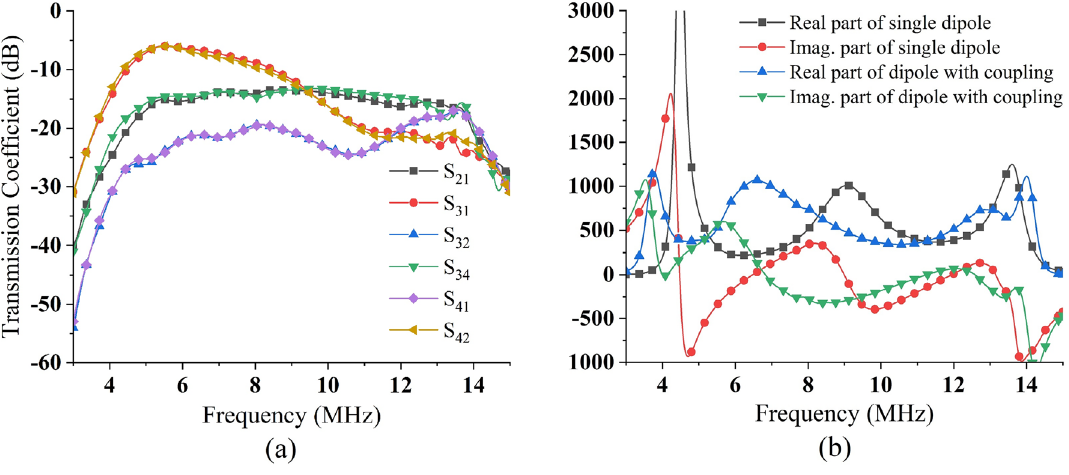
Figure 6. ( a ) Transmission coefficient between four ports (D h = 1 m), ( b ) impedances of the dipole before and after coupling.